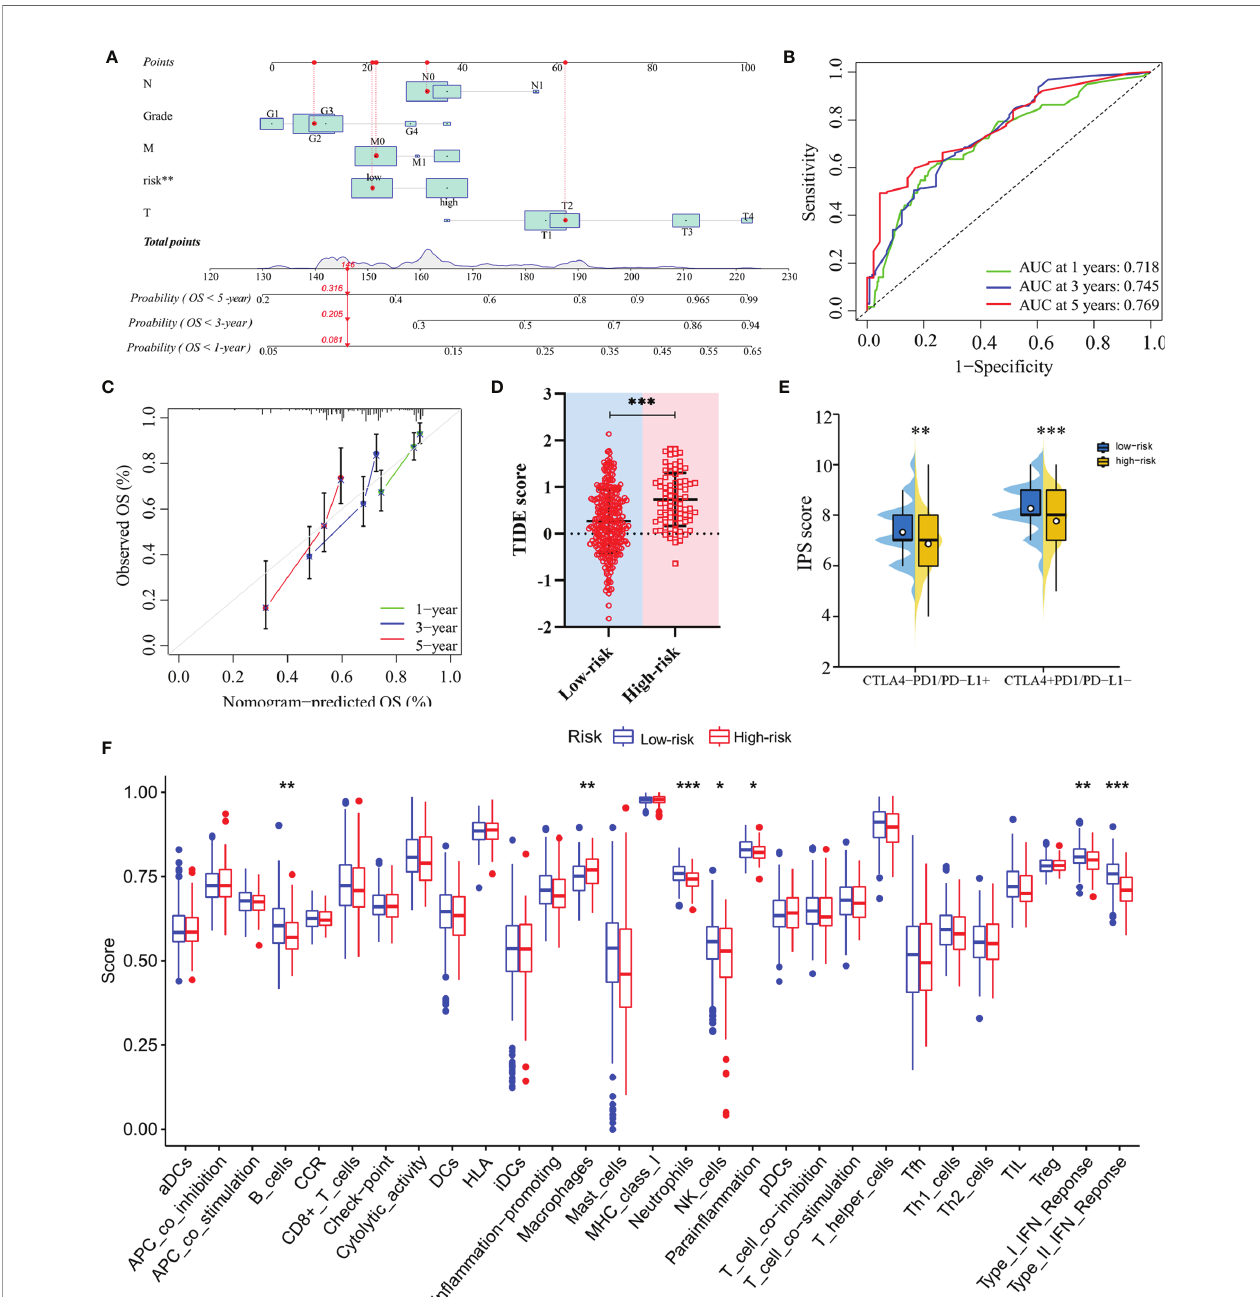
FIGURE 6 | Construction of the nomogram and analysis of immunotherapeutic response. (A) The nomogram for predicting 1-, 3- and 5-year overall survival in TCGA-LIHC cohort. (B) ROC analyses of the nomogram predicting of 1-, 3- and 5-year overall survival. (C) Calibration curve for validation of the nomogram. (D) TIDE scores of high-risk and low-risk groups in TCGA-LIHC cohort. (E) IPS scores of high-risk and low-risk groups in TCGA-LIHC cohort. (F) Single-sample gene set enrichment analysis. *: P < 0.05; **: P < 0.01; ***: P <